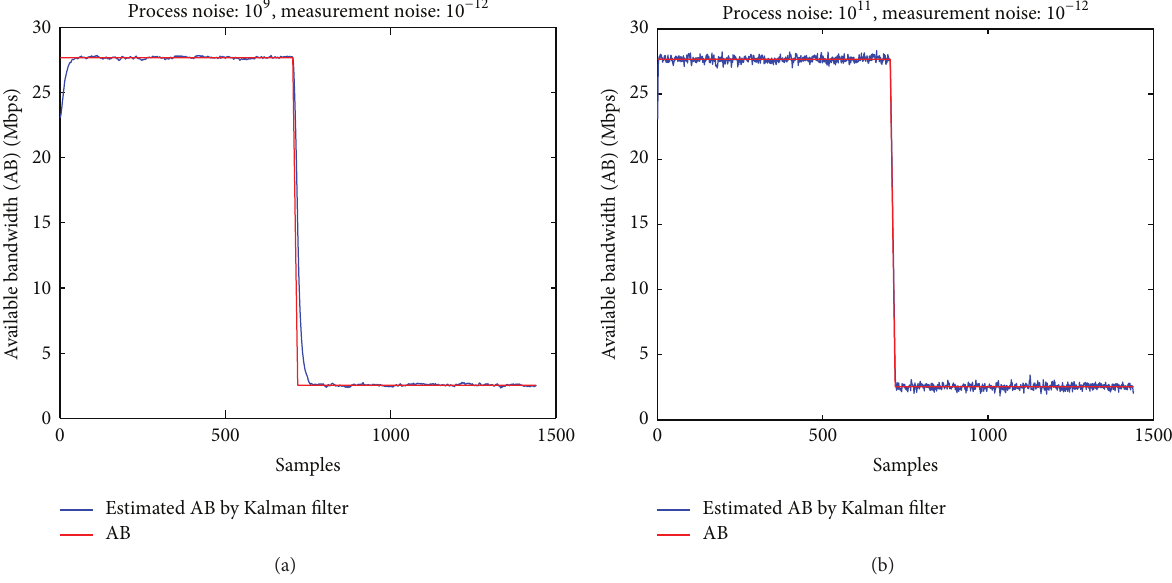
Figure 2: Comparison of the DEKF’s performance for an abrupt AB variation for a value of the covariance matrix of the measurement noise equal to 10 −12 and for two different values of the covariance matrix of the process noise: (a) 10 9 and (b) 10 11 .